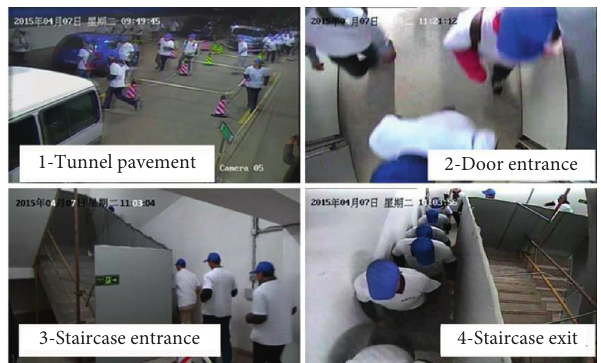
Figure 6: Imagery pictures of evacuation.